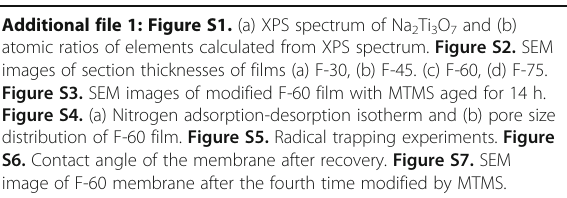
Additional file 1: Figure S1. (a) XPS spectrum of Na 2 Ti 3 O 7 and (b) atomic ratios of elements calculated from XPS spectrum. Figure S2. SEM images of section thicknesses of films (a) F-30, (b) F-45. (c) F-60, (d) F-75. Figure S3. SEM images of modified F-60 film with MTMS aged for 14 h. Figure S4. (a) Nitrogen adsorption-desorption isotherm and (b) pore size distribution of F-60 film. Figure S5. Radical trapping experiments. Figure S6. Contact angle of the membrane after recovery. Figure S7. SEM image of F-60 membrane after the fourth time modified by